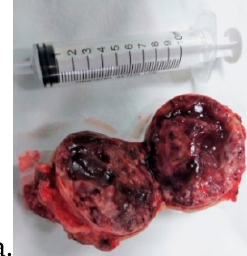
Figure 3. ( a ). Resected tumor showing various blood vessels, areas of necrosis, and clots. ( b ). Details of the resected tumor. ( c ). Histopathological exam offering dilatated venous channels with multiple rows of cuboidal glomus cells. Abnormal collections of glomus cells are noted. Unlike venous malformations, they present single or multiple rows surrounding cuboidal glomus cells. The glomus cells tested positively for vimentin and α -smooth-muscle actin. The three components needed for diagnosis were observed: glomus cells, blood vessels, and smooth muscle cells respectively: glomus cells: are small and uniform, round to oval shaped, with distinctive cell borders, centrally located punched-out nuclei, light eosinophilic or amphophilic cytoplasm; blood vessels: thin-walled, capillary sized, dilated; smooth muscle cells: elongated, mature looking.